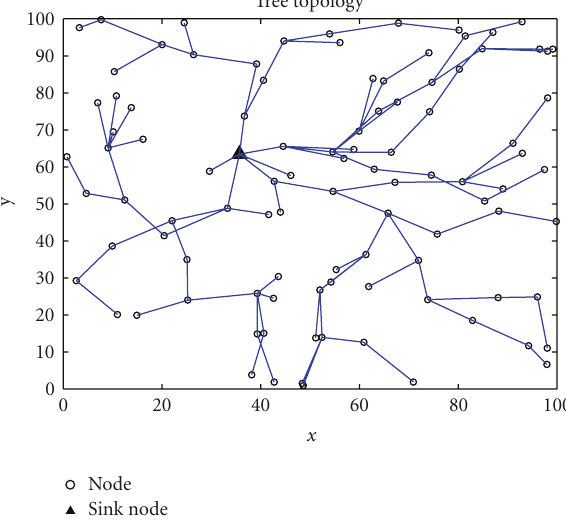
Figure 7: The spanning tree as a result of Bellman-Ford routing algorithm on 100 nodes deployed with uniform distribution.